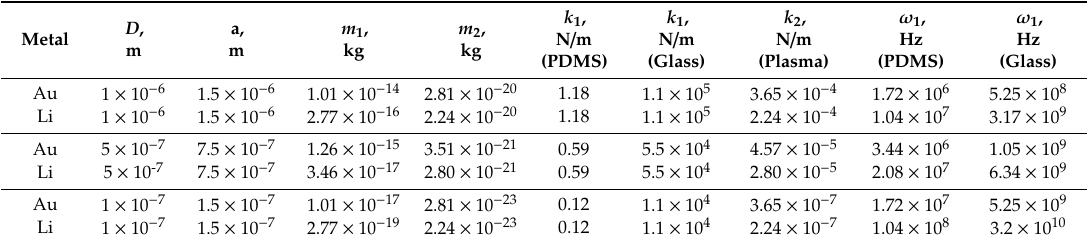
D —diameter of the spherical metallic particle (Figure 2); a —lattice